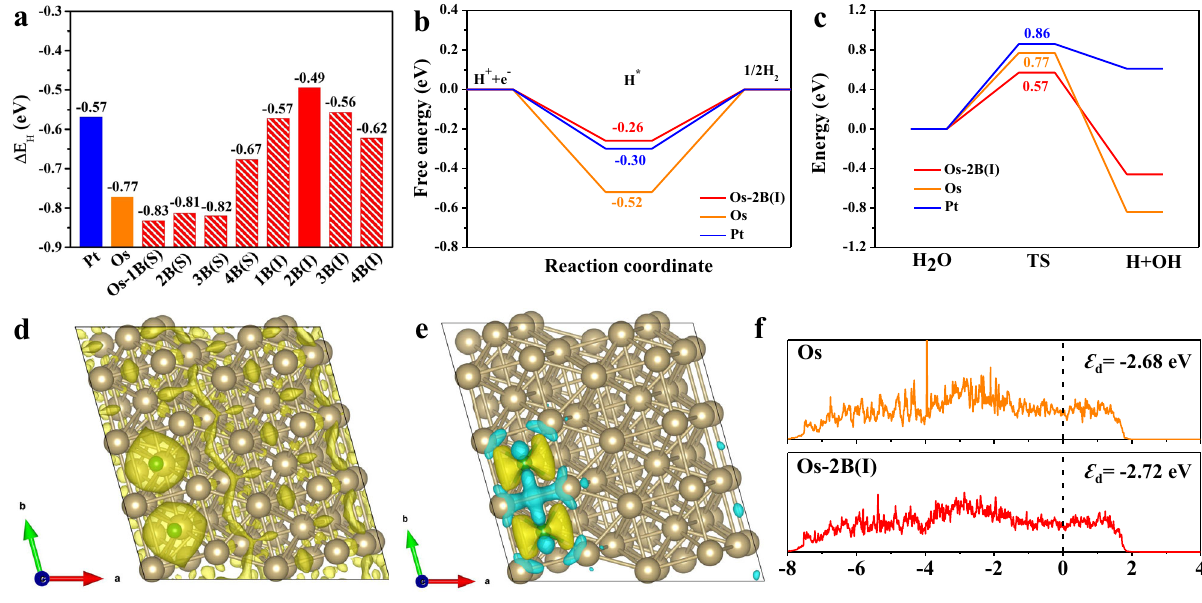
Fig. 5 DFT calculations results. a The H adsorption energy for Pt, Os, and Os with different doping con fi gurations. b Calculated Gibbs-energy diagram of HER at the equilibrium potential (U RHE = 0 V) for Pt, Os, and Os-2B(I). c Calculated energy pro fi le for water dissociation on the Pt (blue), Os (orange), and Os-2B(I) (red) surfaces. In c , the numbers represent the corresponding energy barriers in the units of eV. d Electron-localization function of Os-2B(I). e Charge-density difference plot of Os-2B(I). The yellow (blue) isosurface is drawn at the density of 0.01 ( – 0.01) e Å – 3 . The gold and green circles represent Os and B atoms, respectively. f The density of states (DOS) and d -band center values for Os and Os-2B(I). The zero-energy indicates the Fermi